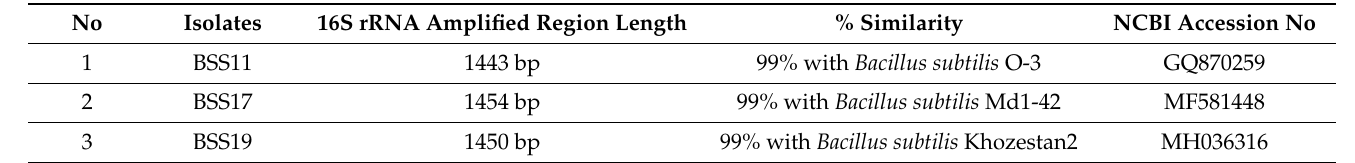
Table 7. Identification of the bacterial species based on the sequence similarities.